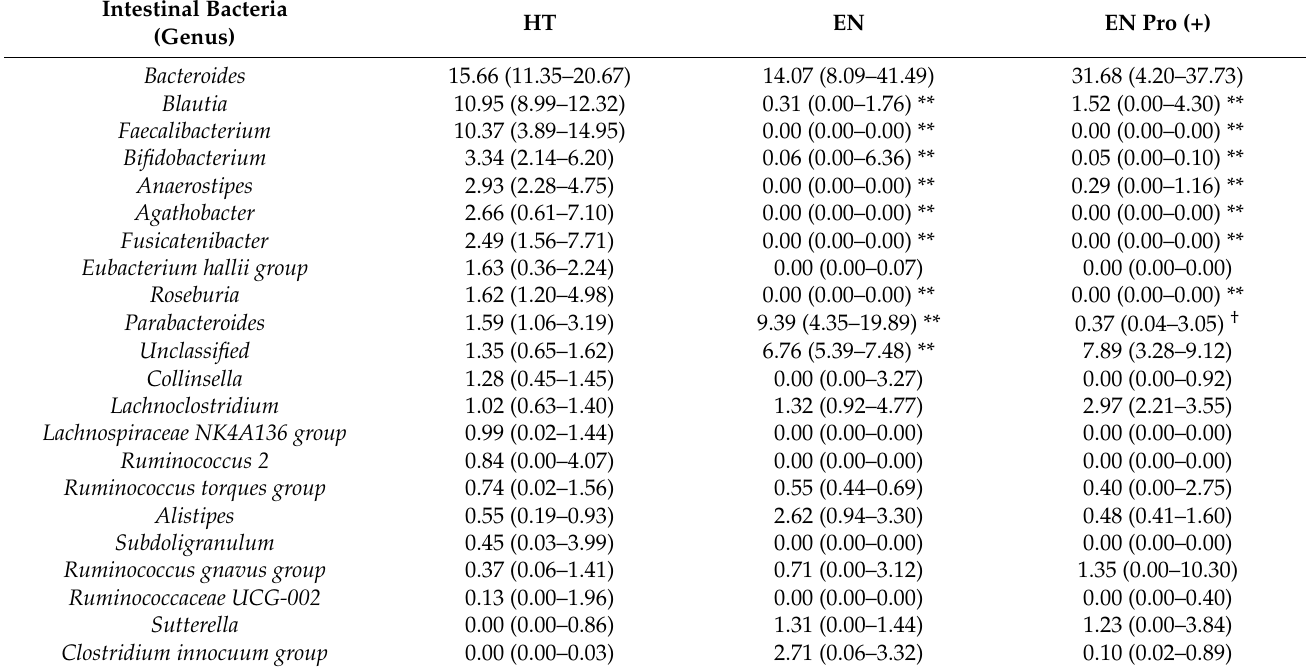
Anaerostipes 2.93 (2.28–4.75) 0.00 (0.00–0.00) ** 0.29 (0.00–1.16) ** Agathobacter 2.66